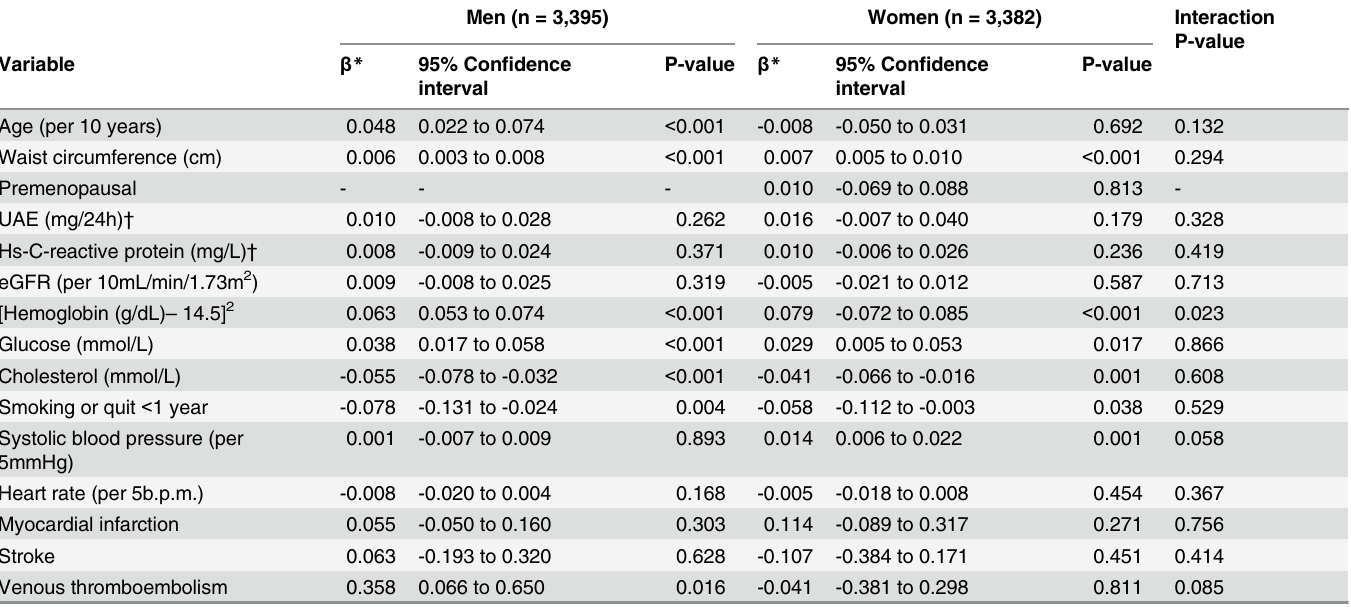
We performed univariable (S4 Table) and multivariable regression (Table 3) separate for men and women because of the significant interaction between hemoglobin and sex on EPO levels. In multivariable regression, the associations between EPO and hemoglobin, waist Table 3. Multivariate linear regression for